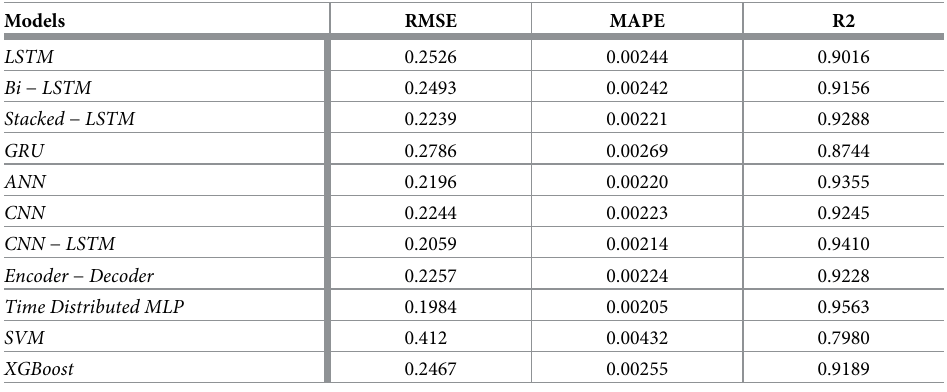
Table 3. Evaluating all the models’